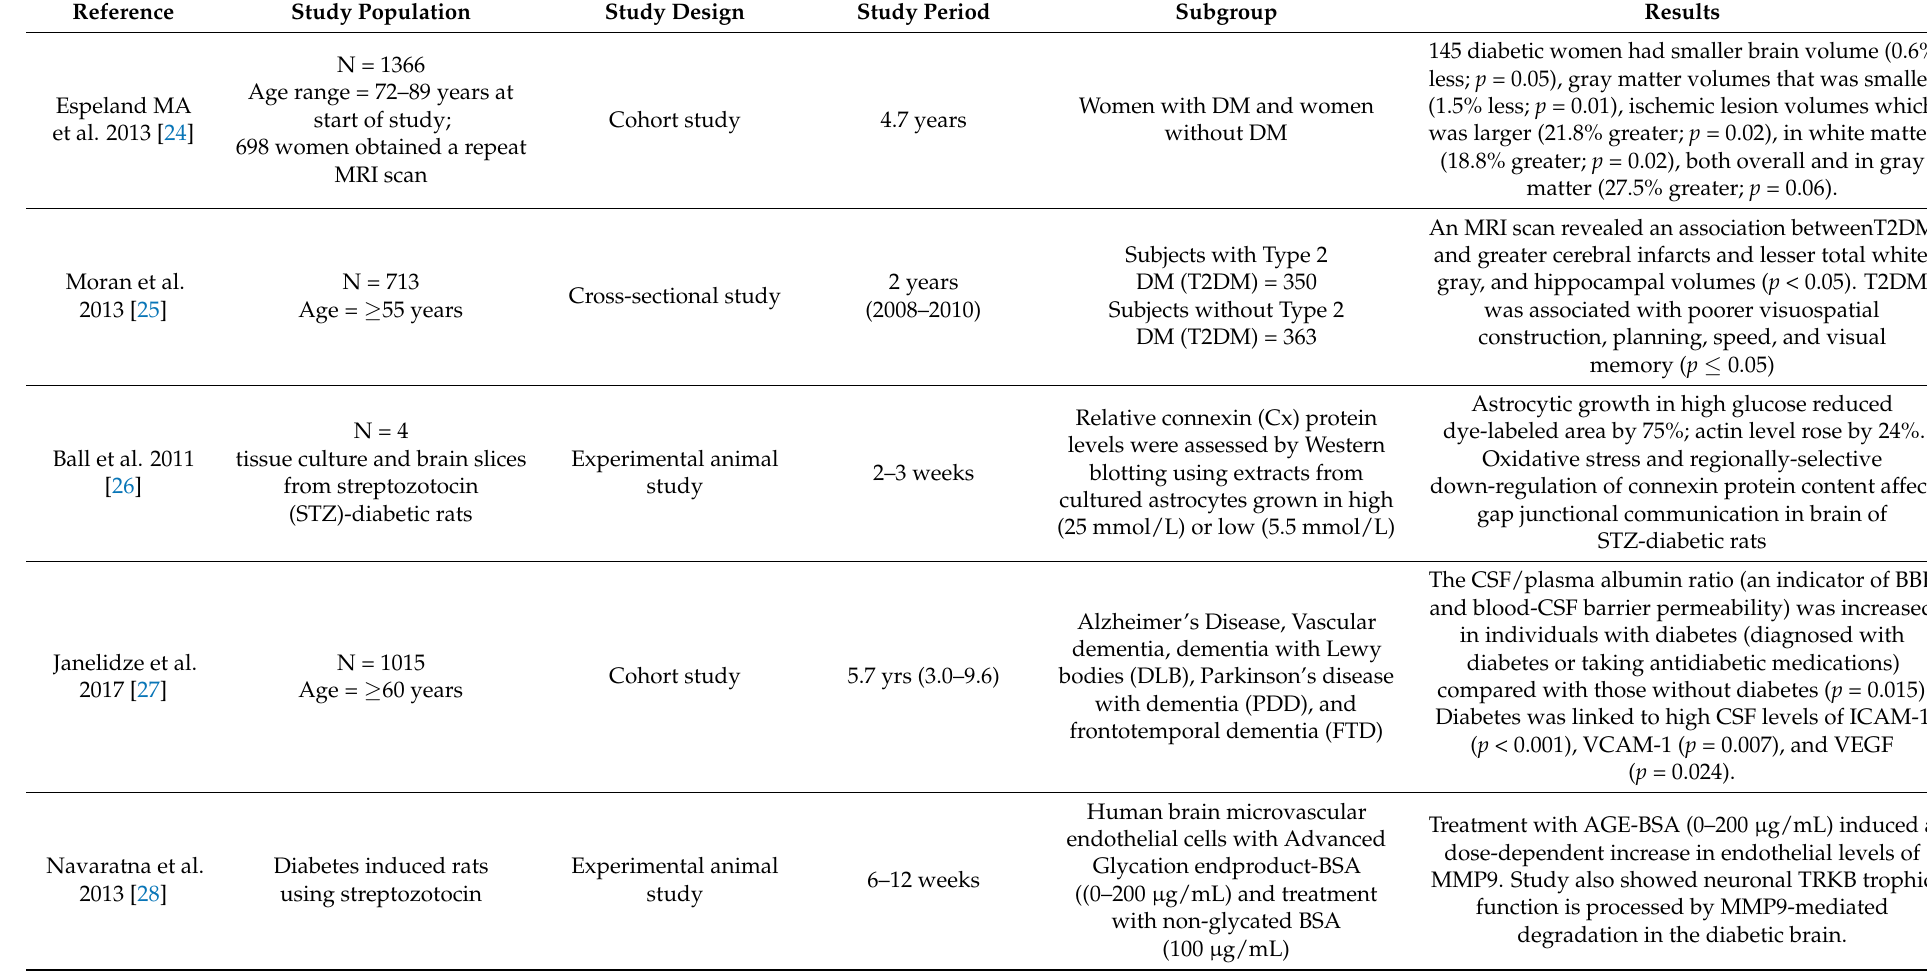
Table 1. Studies Linking Diabetes Mellitus to